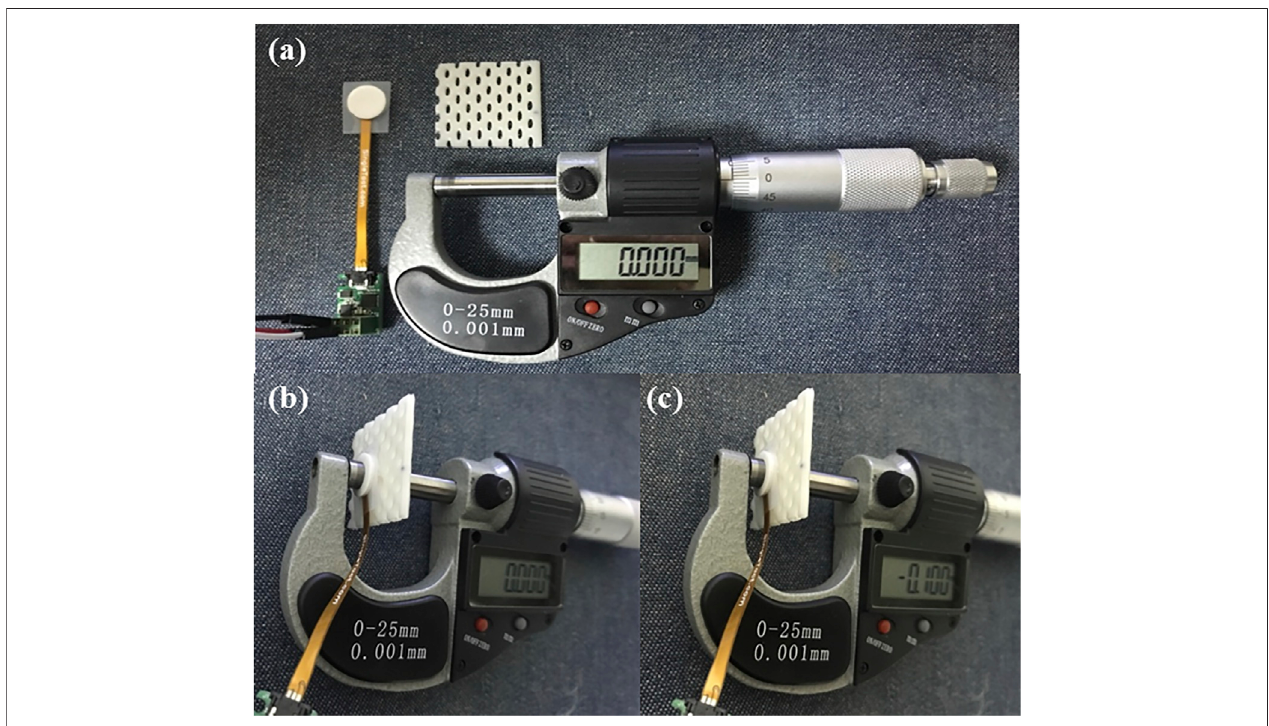
FIGURE3| Experimental settingforthereproducibilitytest ofthesensorunit. (A) Preparematerialsforthetest, thesensorunit, apiece ofthermoplasticmask,and a micrometer; (B) place the sensor unit and the piece of mask between the anvil and spindle of the micrometer, and then set the scale to zero; (C) obtain sensor output values according to different compressing distances with the interval of 0.1